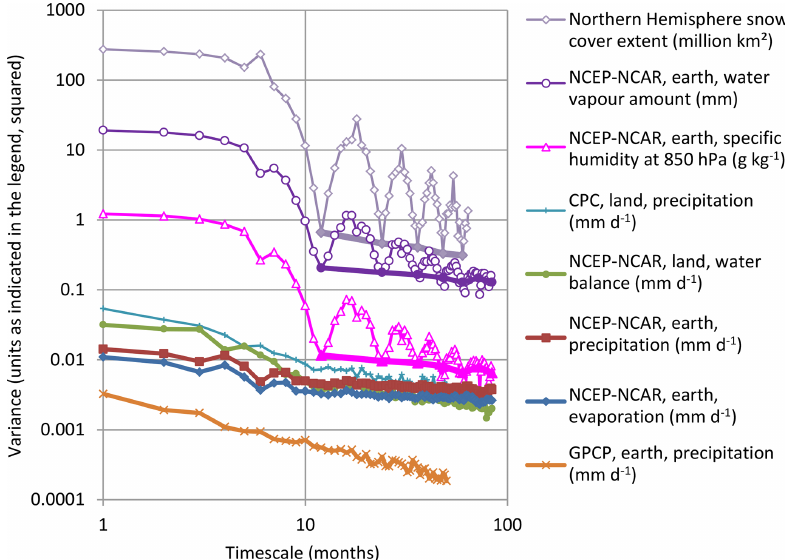
Figure 18. Climacograms of the indicated processes calculated from the monthly time series; for some series with prominent seasonality the climacograms from the annual time series are also plotted with thicker lines of the same colour. For timescales greater than the annual, all slopes in the double logarithmic plots are close to − 0 . 2, suggesting a Hurst parameter of 0.90 (or larger, if bias is taken into account). Exceptions are the NH snow cover extent with a slope of − 0 . 47, suggesting a Hurst parameter of 0.76, and the GPCP precipitation series with a slope of − 0 . 72, suggesting a Hurst parameter of